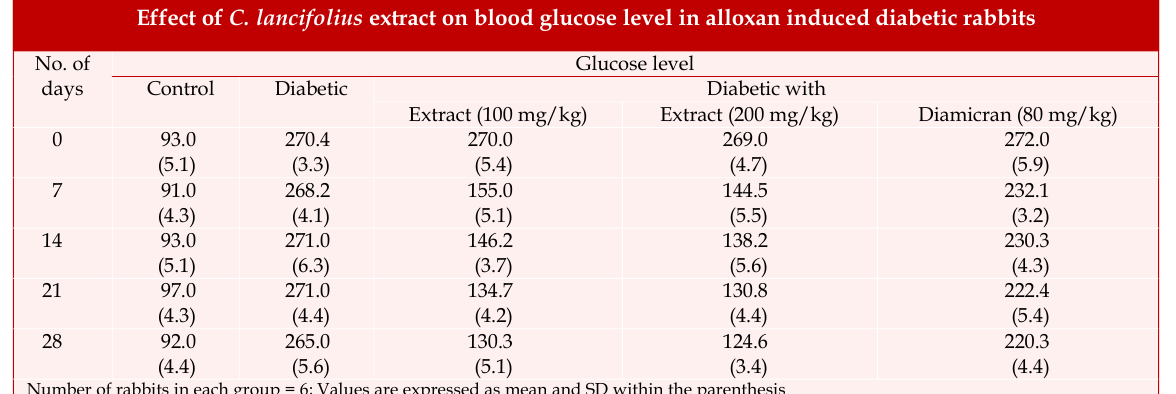
Effect of C. lancifolius extract on blood glucose level in alloxan induced diabetic